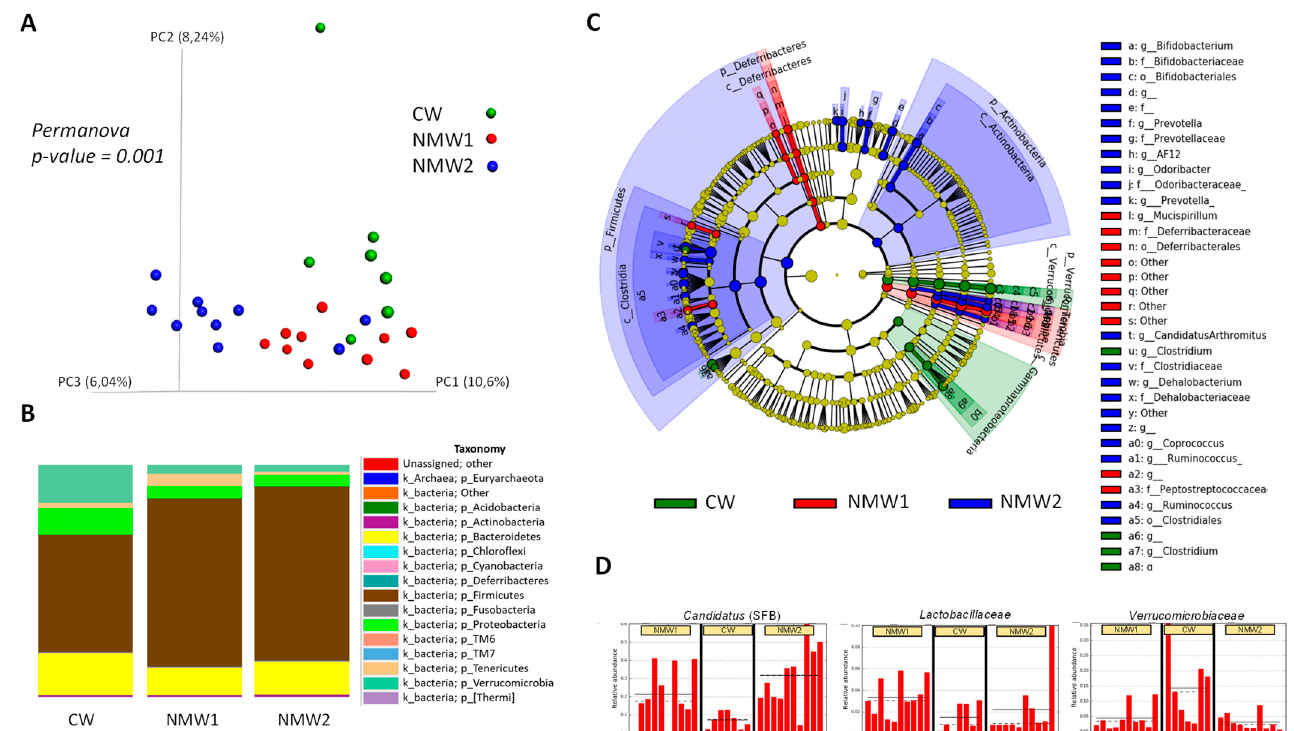
Figure 4. Analysis of the composition of the microbiota associated with the colonic mucosa of mice treated with DSS that received or did not receive NMW1 or NMW2. ( A ) Analysis of beta diversity. ( B ) Comparison of the microbiota at the phylum level. ( C ) Differential analysis of the comparison of the microbiota (LEfSe) between the three conditions. ( D ) Variations in the abundances of different species between the three conditions.